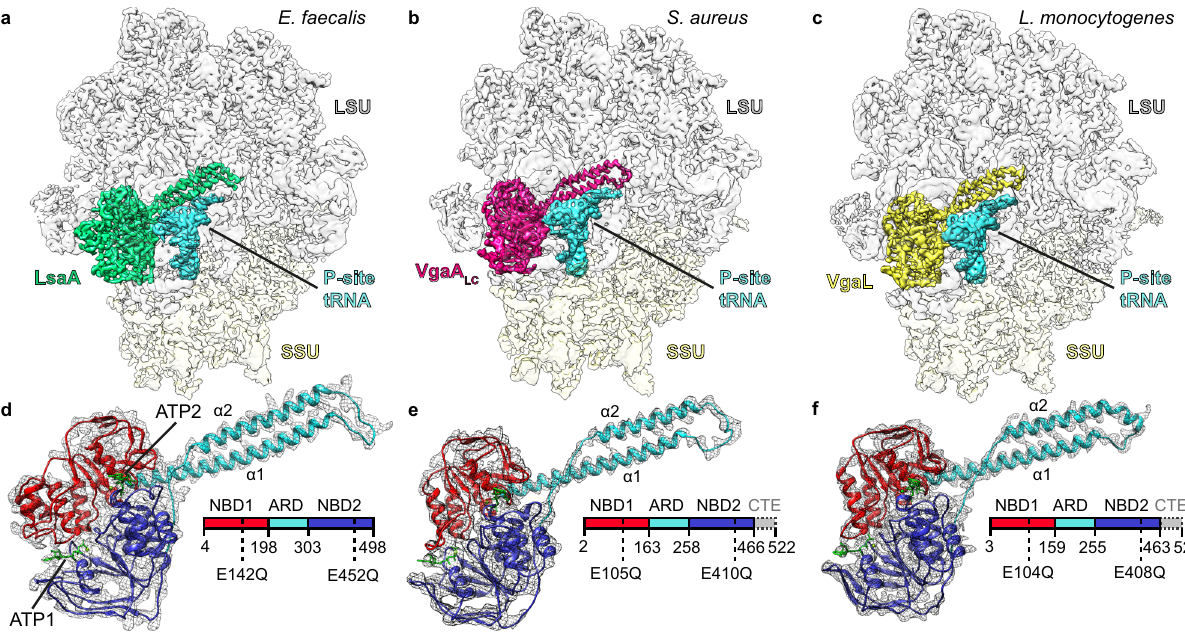
Fig. 1 Cryo-EM structures of ARE-ABCF – ribosome complexes. a – c Cryo-EM maps with isolated densities for a E. faecalis LsaA (green), b S. aureus VgaA LC (magenta), c L. monocytogenes VgaL (yellow) as well as P-site tRNA (cyan), small subunit (SSU, yellow) and large subunit (LSU, grey). d – f Density (grey mesh) with molecular model for d LsaA, e VgaA LC and f VgaL, coloured according to domain as represented in the associated schematics: nucleotide- binding domain 1 (NBD1, red), antibiotic-resistance domain (ARD, cyan), nucleotide-binding domain 2 (NBD2, blue) and C-terminal extension (CTE, grey, not modelled). α 1 and α 2 indicate the two α -helices of the ARD interdomain linker. In d – f , the ATP nucleotides are coloured